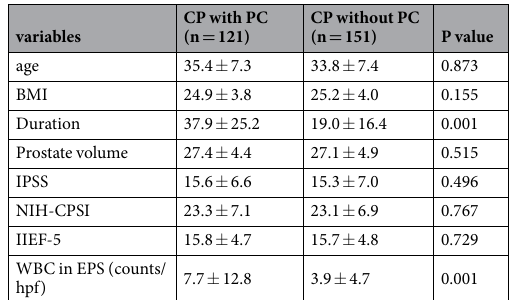
Table 1. Clinical variables between patients with and without prostatic calculi. * Compared the value between the calcification and no calcification groups BMI = body mass index; CP = chronic prostatitis; PC = prostate calification; IPSS = international prostate symptom score; hpf = high power field; NIHCPSI = National Institutes of Health Chronic Prostatitis Symptom Index; IIEF = International Index of Erectile Function; EPS = expressed prostatic secretion; WBC = white blood cell Data are presented as means ± standard deviation,